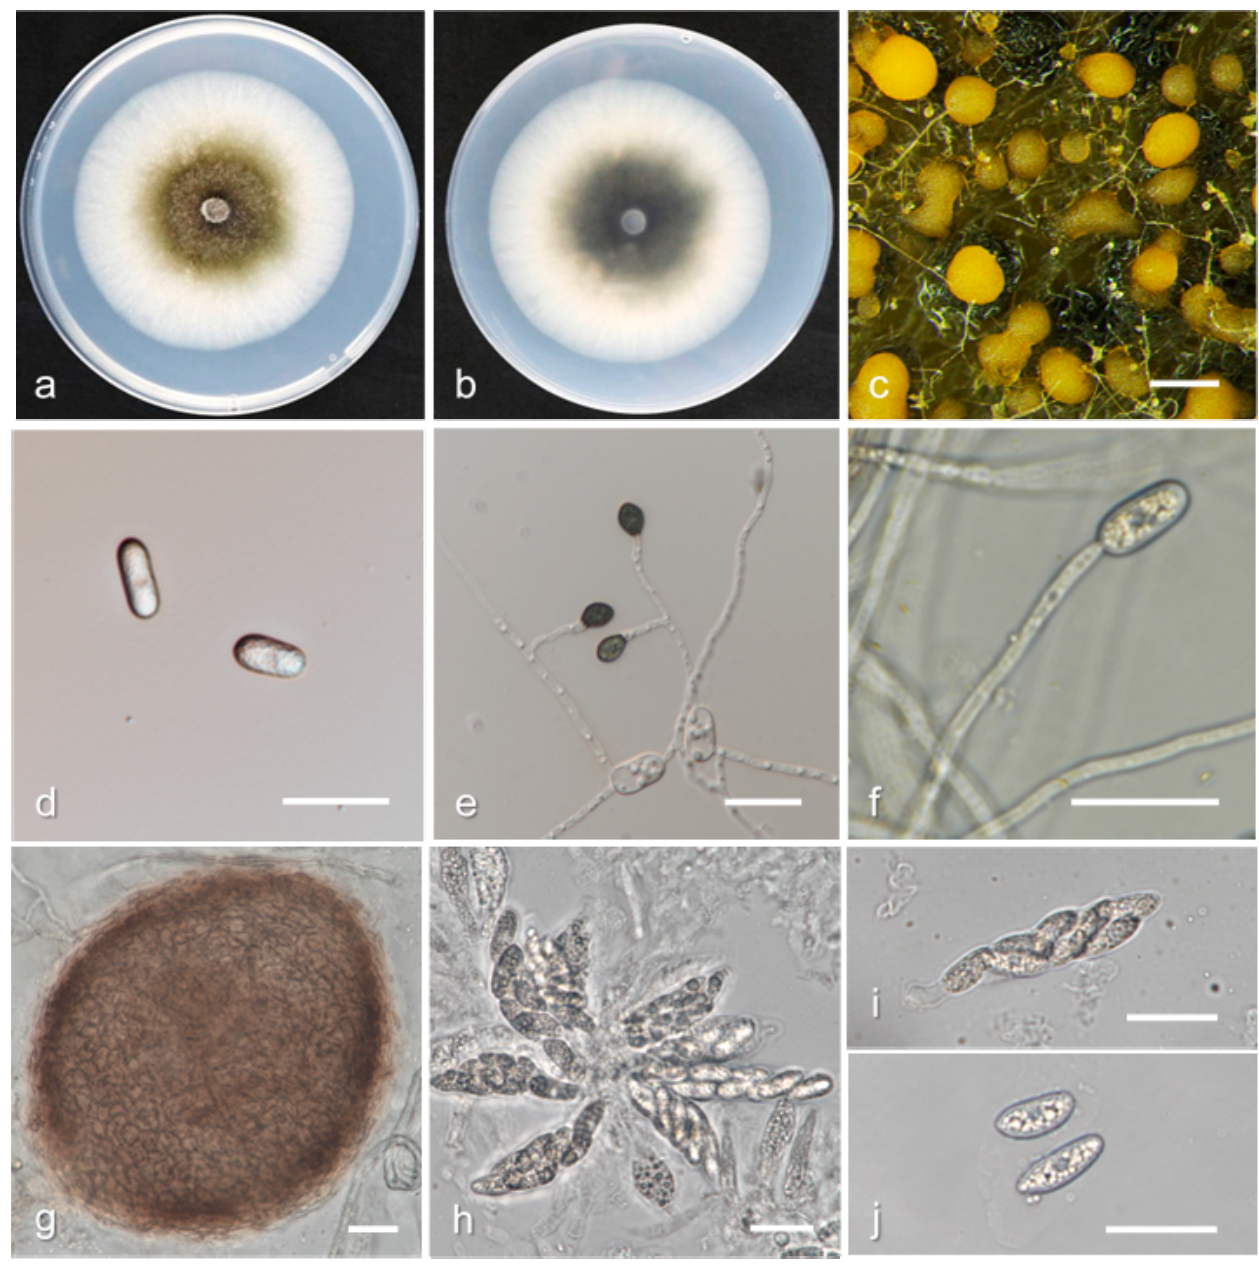
Figure 13. Biological characteristics of Colletotrichum karsti . ( a , b ) Front and back view of six-day-old PDA culture; ( c ) conidiomata; ( d ) conidia; ( e ) appressoria; ( f ) conidiophores; ( g ) ascomata; ( h , i ) asci; ( j ) ascospores (( a – j ) isolate YNHH 3-1). Scale bars: ( c ) = 200 µ m; ( d – j ) = 20 µ m. Colletotrichum folicola Q. Tan and C.X. Luo, sp. nov. (Figure